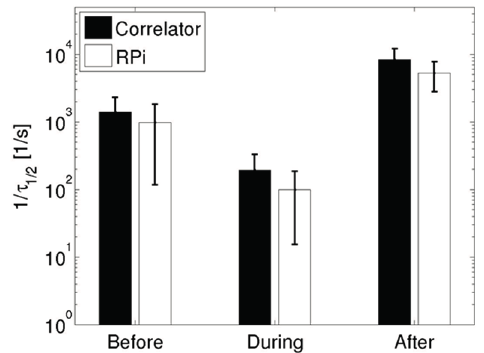
Figure 5. Parametrized 1/ τ ½ values before, during, and after cuff occlusion for the in vivo experiments for data acquired using the hardware correlator (black bars) and the Raspberry Pi (white bars). The bars indicate mean values from three repeated measurements while the error bars indicate the standard